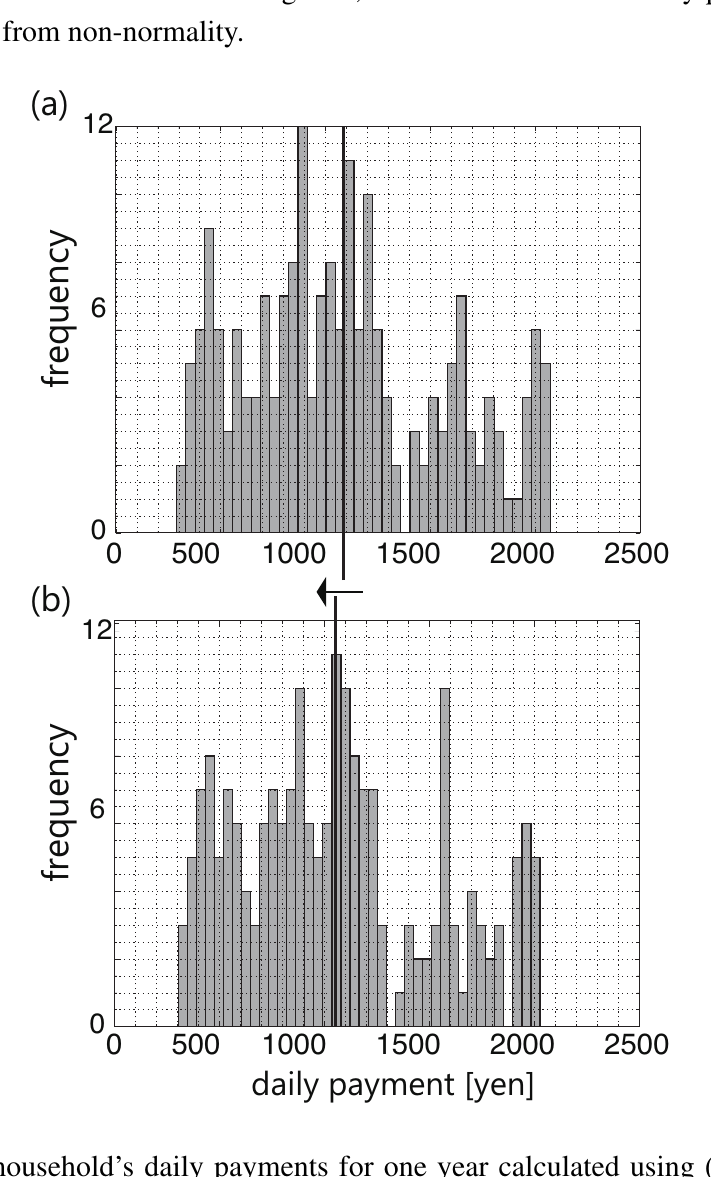
Figure 6. The household’s daily payments for one year calculated using ( a ) the gaussian predictive distributions and ( b ) the normalized frequency distributions. Bold vertical line shows the mean value of each